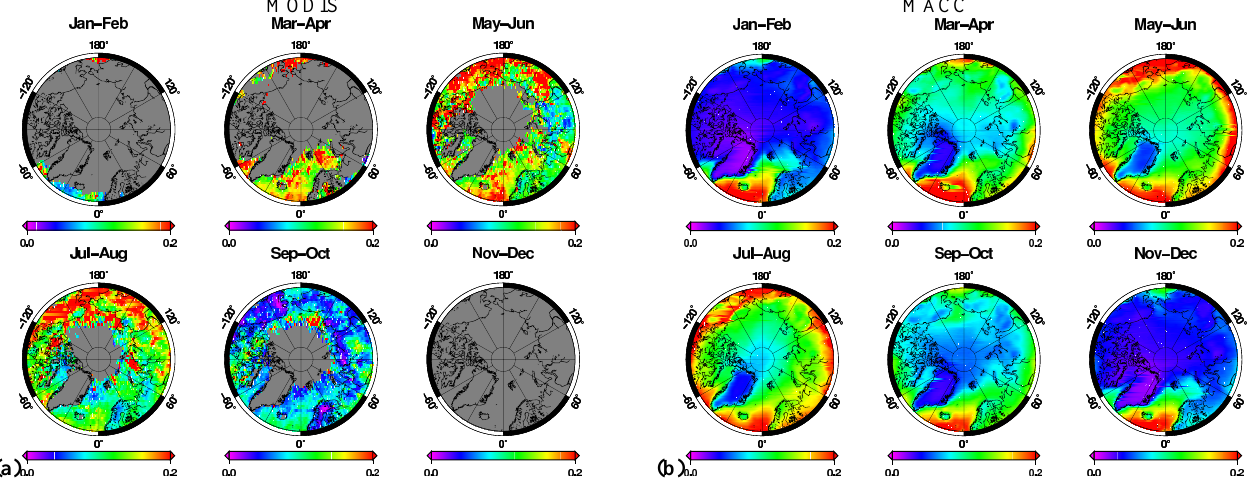
Fig. 5. Maps of average AOD in different periods of the year. Monthly means are calculated in the period 2003 to 2006, common to all datasets. Panels: (a) MODIS Terra, (b) MACC. Grey areas indicate missing